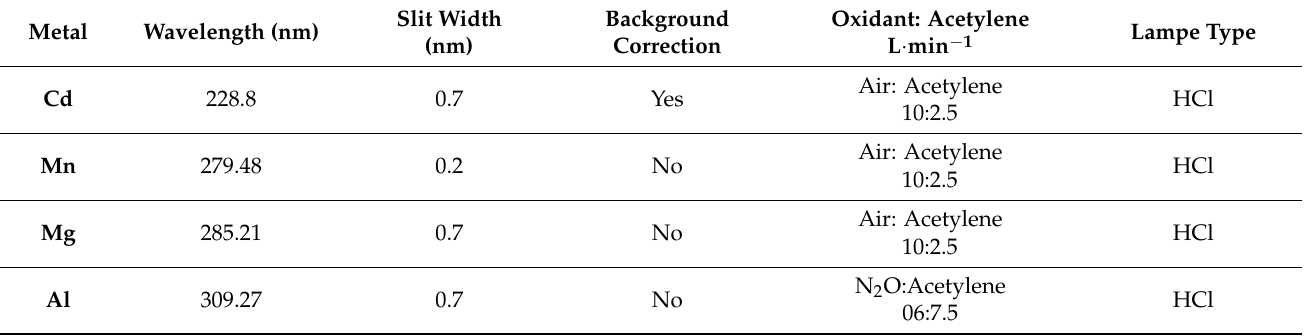
Table 2. Instrumental parameters for flame atomic absorption spectrometer FAAS of TME analysis.